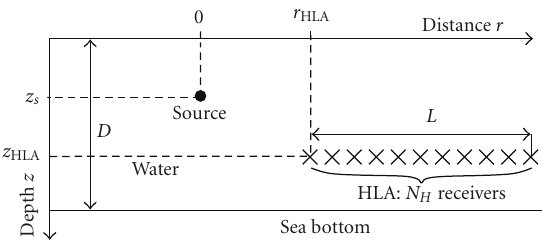
Figure 5: Experimental